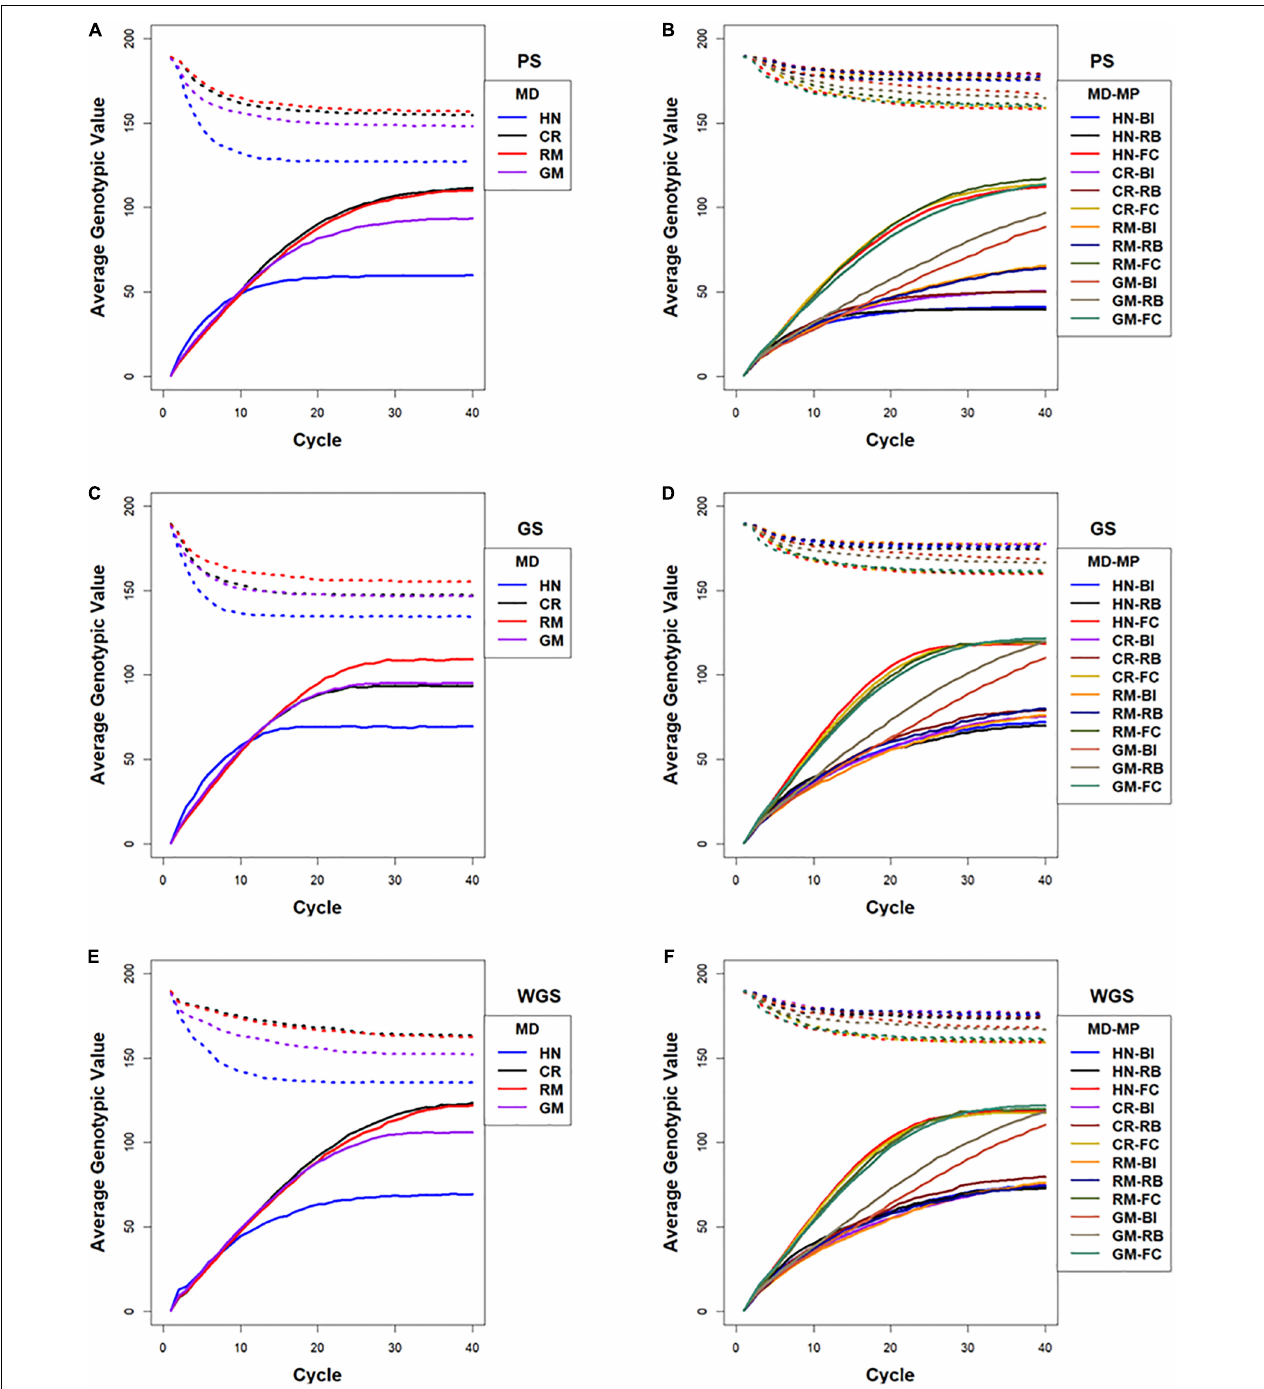
FIGURE 7 | Lost genotypic potential and average genotypic values across 40 cycles of recurrent selection on centralized (A,C,E) and family island (B,D,F) populations, using Phenotypic Selection (PS) (A,B) , Genomic Selection (GS) (C,D) and Weighted Genomic Selection (WGS) (E,F) and four mating designs (MD): Hub Network (HN), Chain Rule (CR), Random Mating (RM), and Genomic Mating (GM). Ten percent of lines are selected for crosses using HN, CR, RM, and GM mating designs. The genetic architecture in the initial simulated founder lines consisted of 400 additive QTL uniformly distributed throughout the genome and expressed broad sense heritability on an entry mean basis of 0.7. The dotted lines represent maximum genetic potential estimated from favorable alleles that are lost from the population, and solid lines represent increase in average genotypic value of populations due to recurrent selection. Migration policies (MP) in the island models included “Best Island” (BI), “Random Best” (RB), and “Fully Connected” (FC) with bidirectional exchange of two immigrants and emigrants every other cycle of selection. GP models are updated every cycle in GS and WGS using training sets with data from all prior cycles of selection.